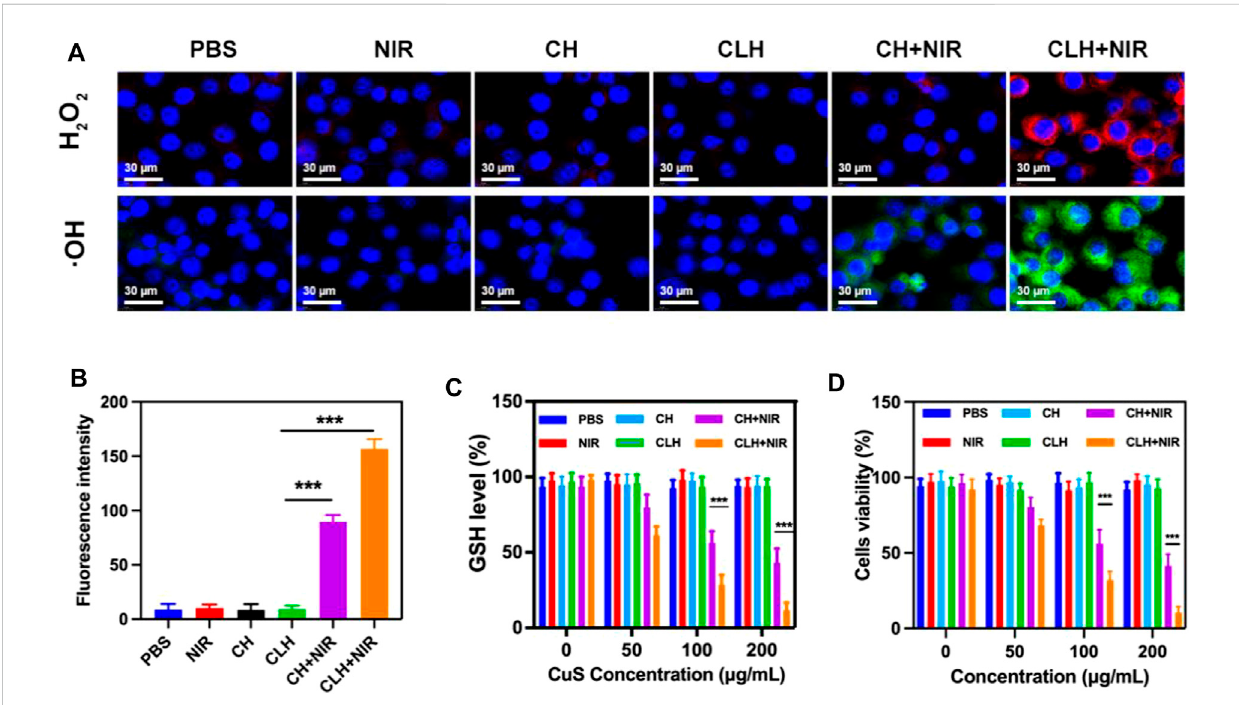
FIGURE 3 (A) Fluorescence images of ROS production in A549 cells following various treatments. (B) Fluorescence intensity of OH from Figure 3A. (C) The effectofdifferentformulationsonintracellularGSHlevels( n =3). (D) CytotoxicityofdifferingdosesofCuSNPsonA549cells.( n =3).* p < 0.05,** p < 0.01, *** p < 0.005; Student ’ s